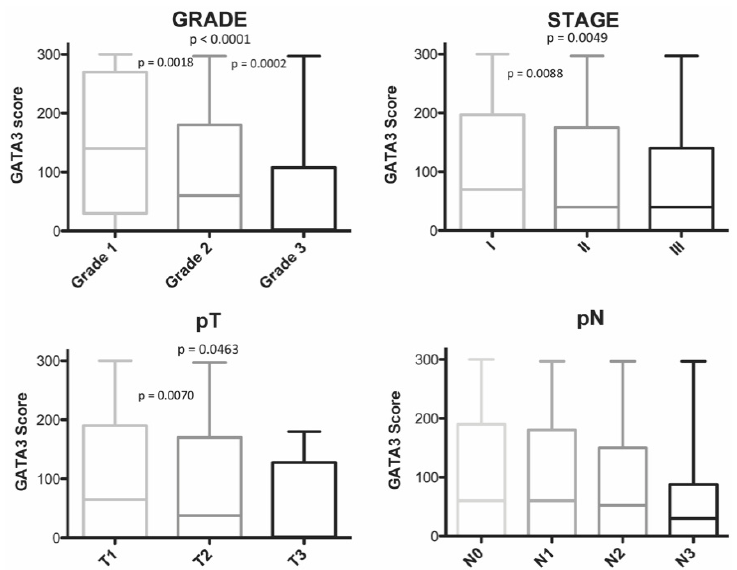
Figure 3. Box plot showing the correlation between GATA3 score and histological grade, stage grouping, pathological primary tumor size (pT), and pathological lymph node involvement (pN). Significant p -values from two-sided t -test comparisons are reported.